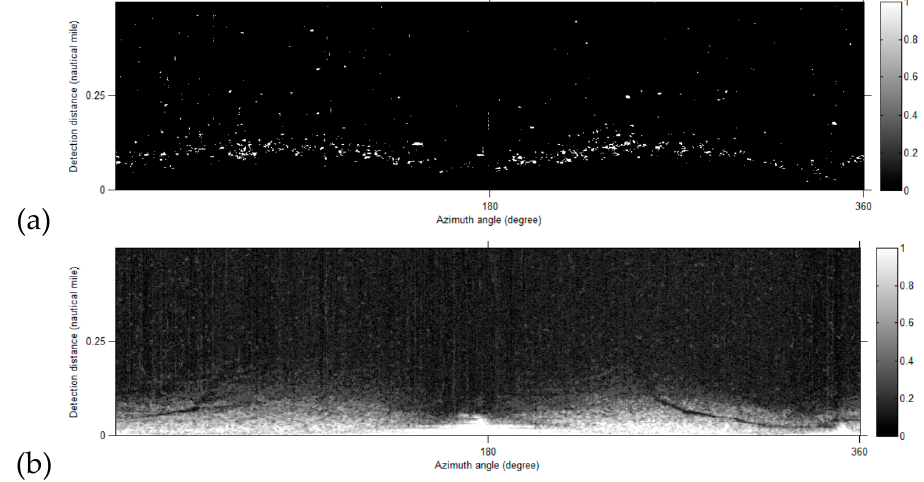
Figure 8. Noise reduction of Figure 7d: ( a ) Noise extraction; and ( b ) median filtering. T grey = 100, T area = 200, and the median filtering window is 21 × 21.